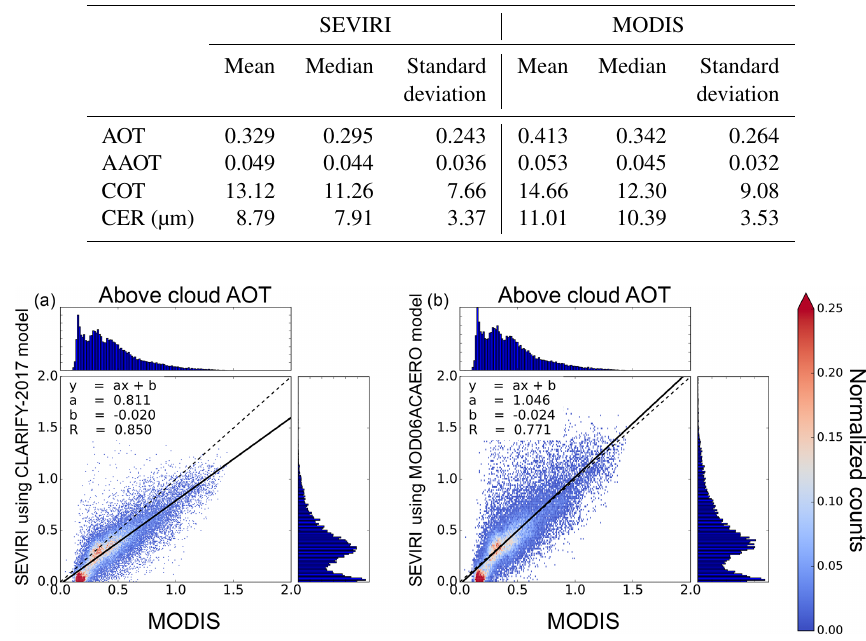
Figure 4. Comparison of the above-cloud AOT retrieved by SEVIRI and MODIS (MOD06ACAERO) in the morning of 4 September 2017 over the area between 0 ◦ N–30 ◦ S and 20 ◦ W–15 ◦ E. Panel (a) corresponds to the SEVIRI retrieval using the CLARIFY-2017 aerosol model, and panel (b) shows the SEVIRI retrieval using the same aerosol model as the MODIS retrieval. The solid lines represent the linear regression, and the dashed lines are the 1:1 lines. R corresponds to the Pearson’s correlation